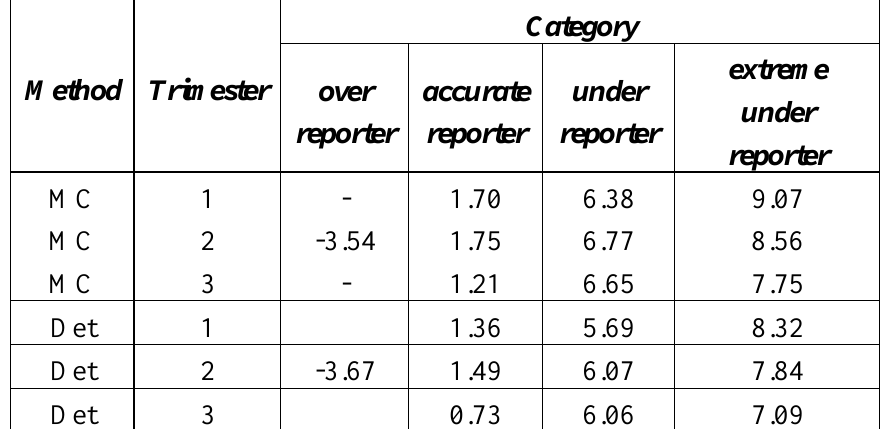
Table 3. Average numbers of adjusted cigarettes in each category over trimesters using group-correction